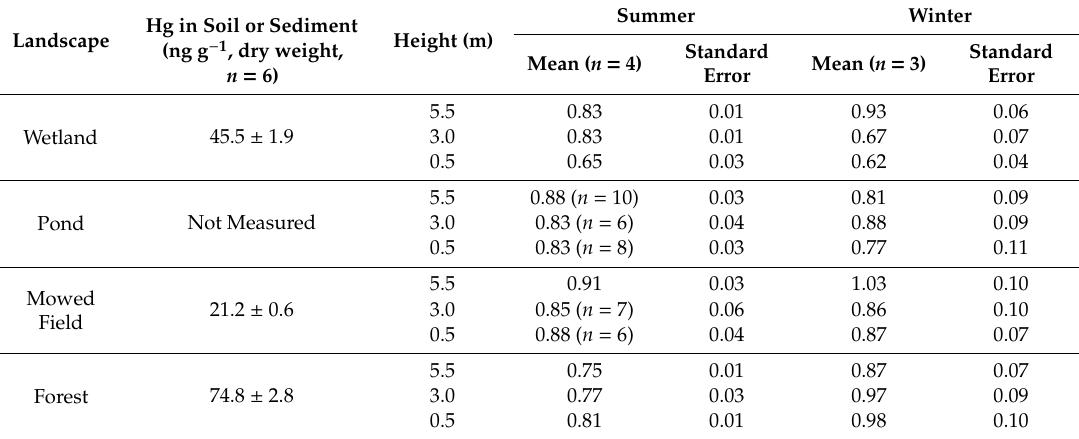
Table A2. Gaseous elemental mercury concentration (ng m − 3 ) at three di ff erent heights at adjacent landscapes in Mississippi,